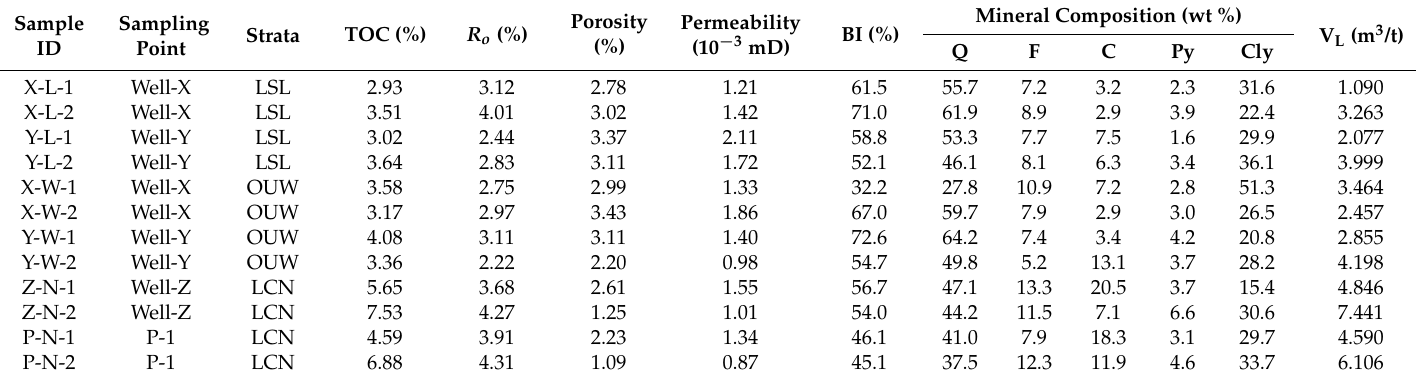
Table 1. Characteristics of the collected shale